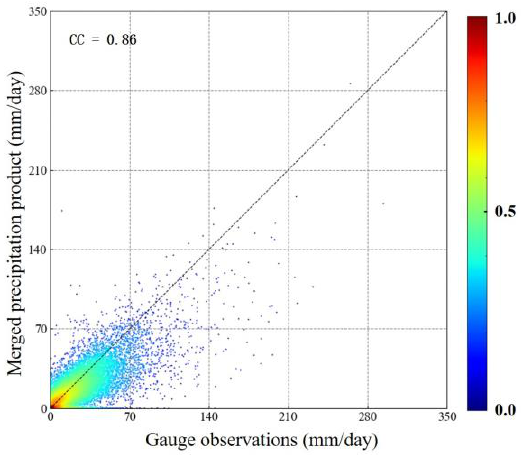
Figure 6. Scatter density plots between gauge observations and the final MPP generated by the GWR-LSTM framework from 2007 to 2018.